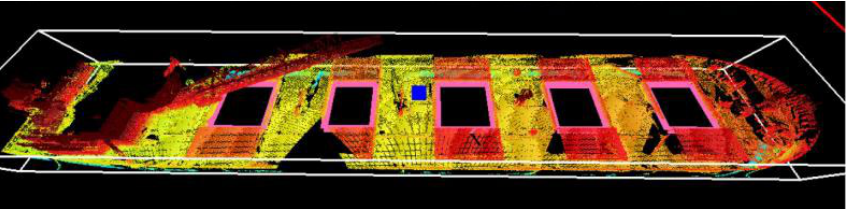
Fig. 5. 3D Scan of a bulk carrier